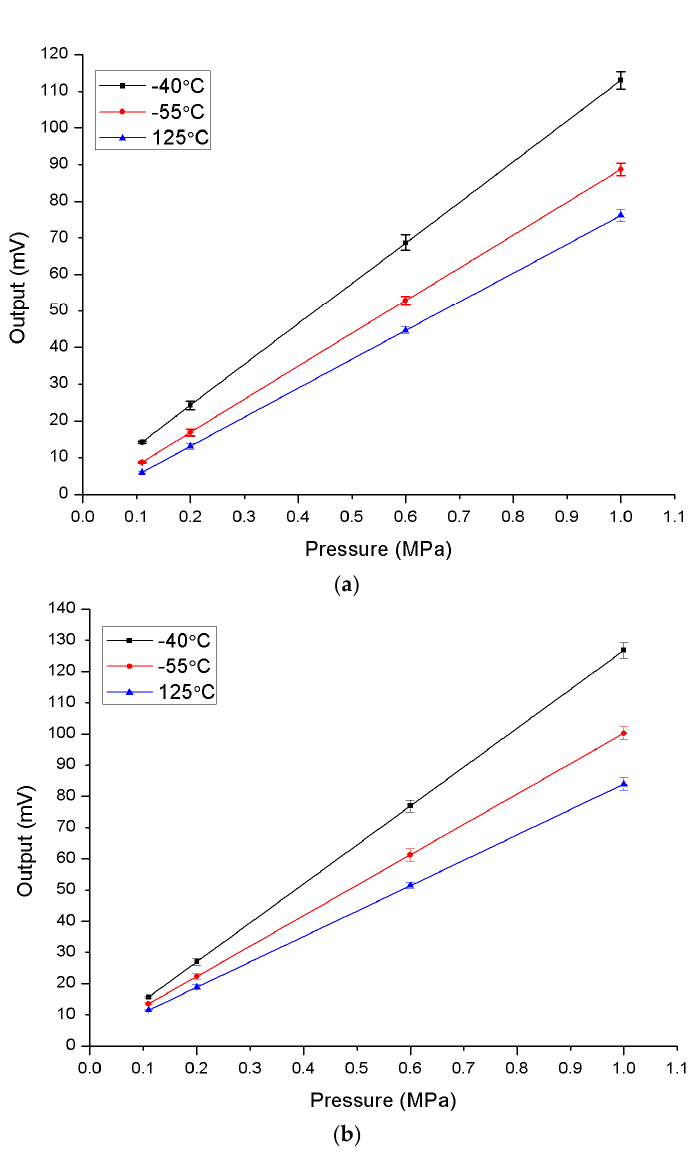
Figure 9. Characteristics of the pressure sensor with ( a ) and without ( b ) a shield layer at different temperatures. Table 3. Outputs of pressure sensor with a shield layer versus temperature ( T ) and pressure ( P ).